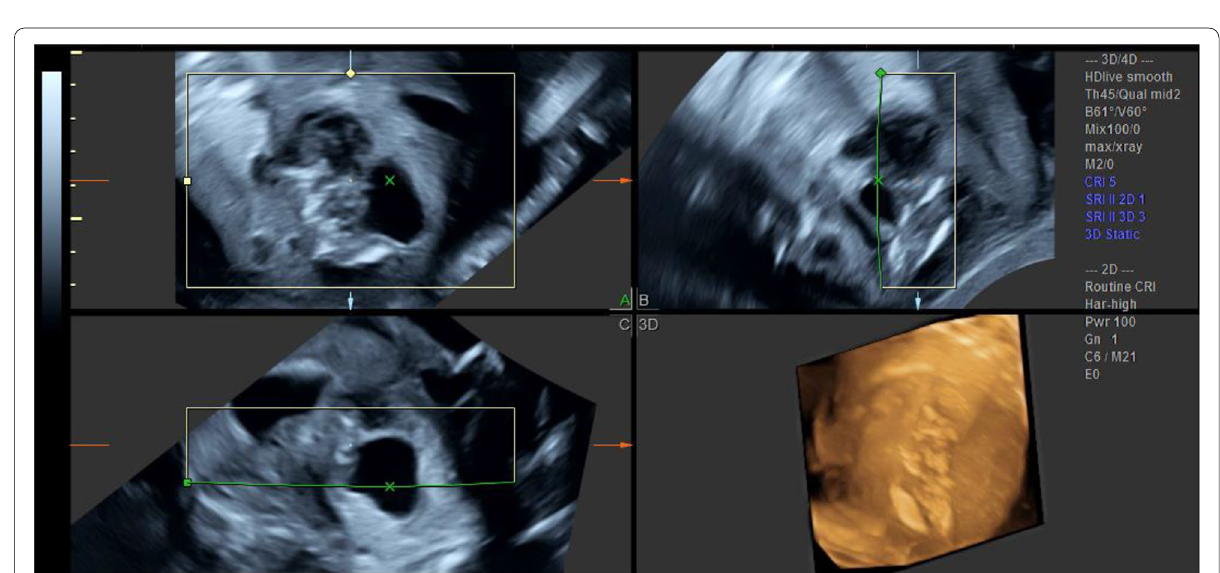
Fig. 2 4D pregnancy ultrasound of the